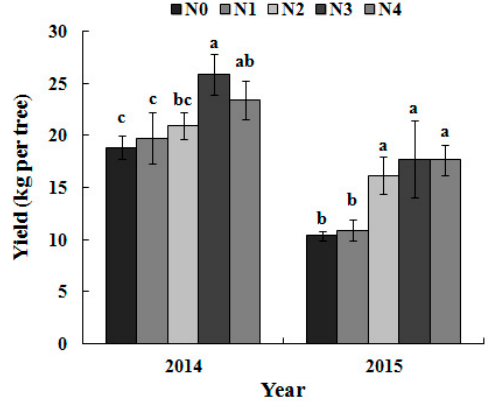
Figure 8. Fruit yields in different N treatments.